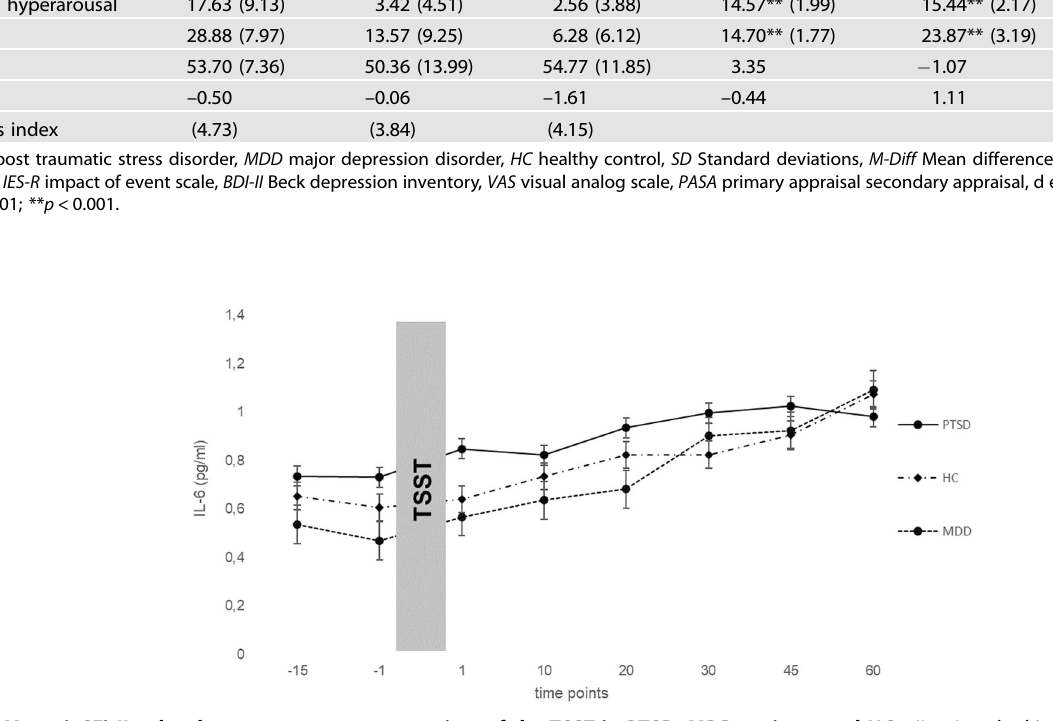
Fig. 1 Mean (±SE) IL-6 levels across measurement points of the TSST in PTSD, MDD patients and HCs. IL-6 Interleukin-6, TSST trier social stress test, PTSD post traumatic stress disorder, HC healthy controls, MDD major depression disorder, time points in minutes.